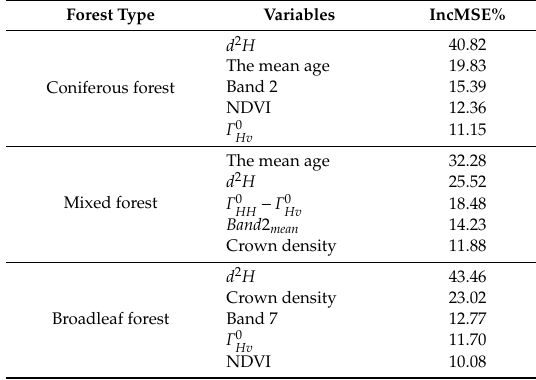
Table 5. The IncMSE% of the top five most important variables in the biomass fitting of di ff erent forest types in the random forest model.